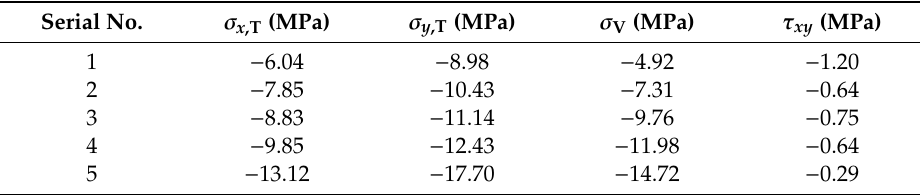
Figure 9. The coordinate systems of the three-dimensional numerical model (XOY) and measured in-situ stresses (NOW). Table 3. The converted in situ stresses of rock masses.